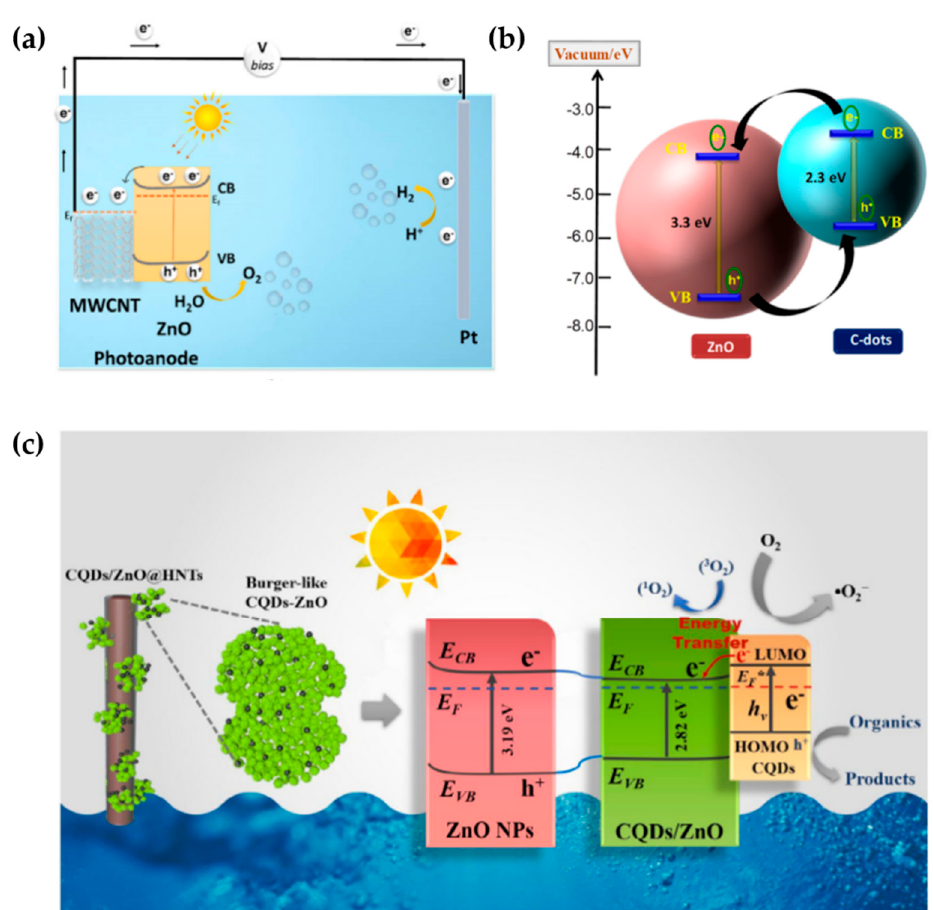
Figure 5. Schematic mechanism illustration of the band con fi guration and the charge separation during the photocatalytic process in ( a ) CNTs/core–shell ZnO. Reprinted with permission from [76]. Copyright 2022 MDPI. ( b ) CDs/nanosheets ZnO. Reprinted with permission from [2]. Copyright 2020 American Chemical Society. ( c ) CQDs/3D burger–like ZnO. Reprinted with permission from [78]. Copyright 2019 Elsevier.